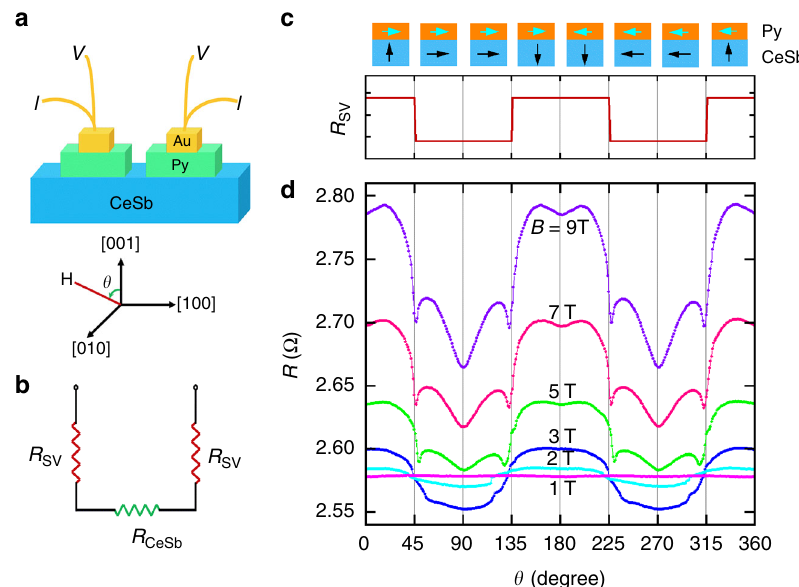
Fig. 4 Probing orbital fl ops using a spin-valve like structure. a Schematics of the structure of Sample B (see Supplementary Fig. 9 for an optic image) and the de fi nition of θ for the magnetic fi eld direction. This sample has only two contacts of ferromagnetic permalloy (Py) fabricated via sputtering-deposition. The interface between the Py contact layer and the CeSb crystal forms a spin-valve like structure. The magnetic fi eld is rotated in the same (100) plane as that for Sample A. b Equivalent circuit for Sample B. R SV and R CeSb represent the resistances at the Py/CeSb interface and in the CeSb crystal, respectively. c Orientations of the magnetic moments in the Py layer and in the CeSb crystal at various orientations of an applied high magnetic fi eld (e.g., ≥ 5T). A schematic of the expected angle dependence of the interface resistance R SV . d Angle dependence of the measured total resistance R = 2 R SV + R CeSb of Sample B at T = 3 K and various magnetic fi elds/orientation. The spin-valve like behavior described in ( c ) is re fl ected by the signi fi cant suppression of the magnetoresistances at 45° < θ < 135° and 225° < θ < 135° compared to those at 0° ≤ θ < 45°, 135°< θ < 225° and 315°< θ ≤